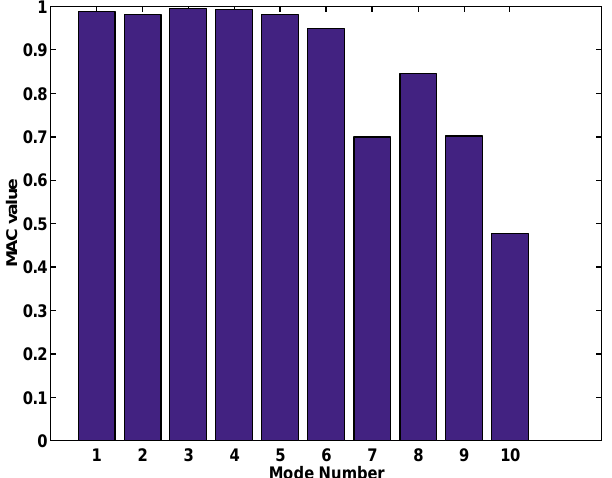
Fig. 7. MAC values between damaged and undamaged states, for MLE mode shapes.